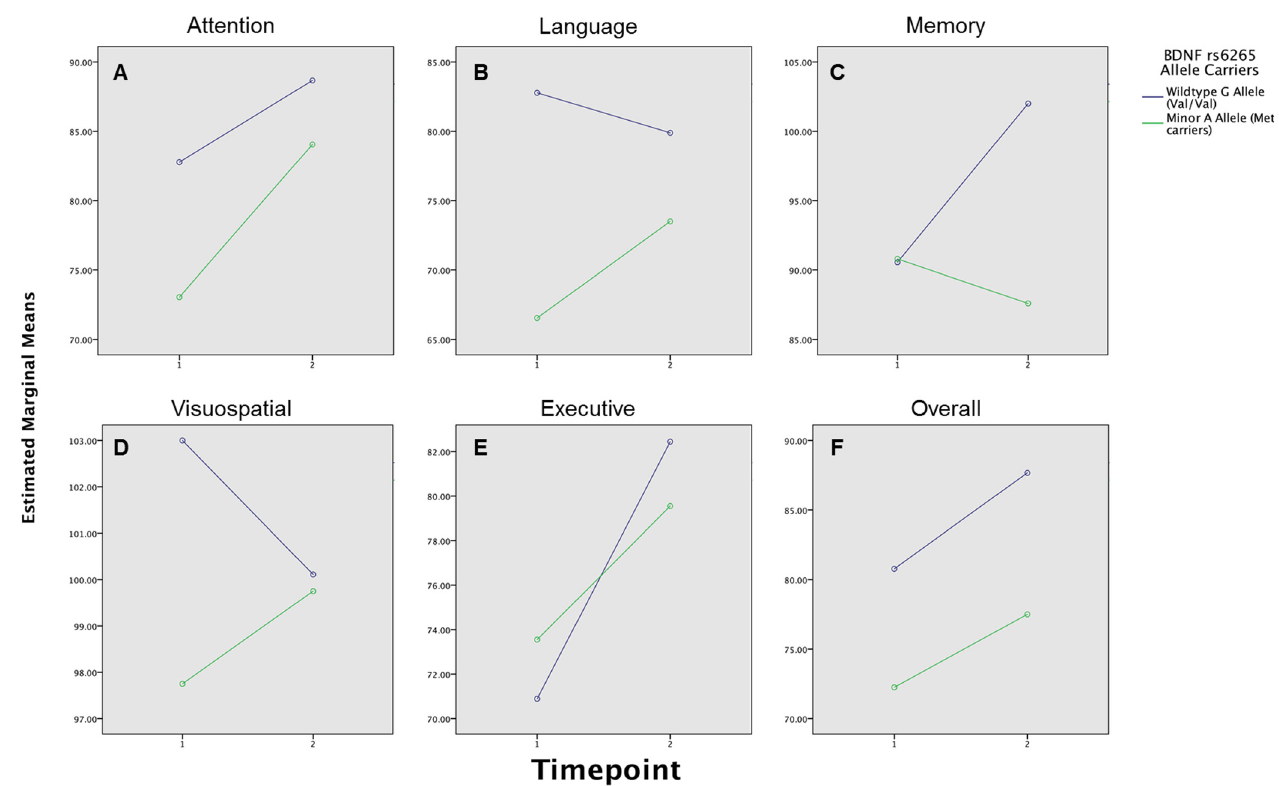
Fig 6. Estimated marginal mean of patients with mTBI, stratified according to their genetic allele status and their domain specific neuropsychological test standard scores across timepoints. (A) Non-significant changes in the attention domain standard score (SS) overtime, with Met carrier performing poorly in the acute stage. (B) Non-significant changes in the language domain standard score (SS) overtime, with the Met carriers, performing poorly acutely, and remaining so overtime. (C) Significant interaction between the allele carrier status and change in memory SS over time with the Met allele carriers showing signs of deterioration at 6 months post trauma. (D) Non- significant changes in the visuospatial SS, intact in both allele groups. (E) Non-significant interactions between allele carrier status and neurocognitive performance within the domains of executive function, with the SS recovery rate being slower in the Met allele carriers. (F) Non-significant changes in the overall index SS, with the Met allele carriers remaining impaired over time.